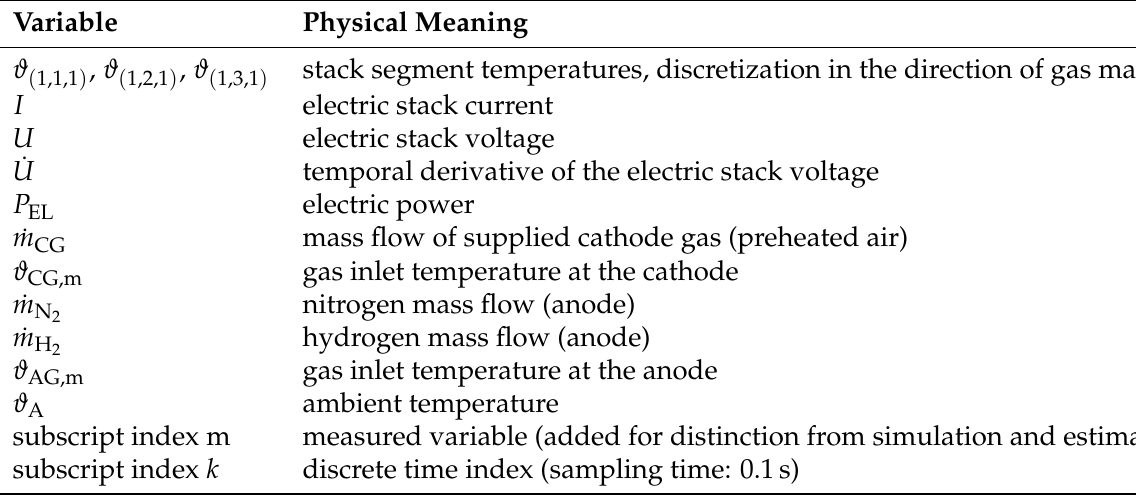
Table 2. Optimal network input selection for the neural network representations of the electric power characteristic according to Figure 2 (first row) and 5 (second row), where ˙ m N anode and cathode gas components, respectively, while ϑ A is the ambient temperature. Network Type